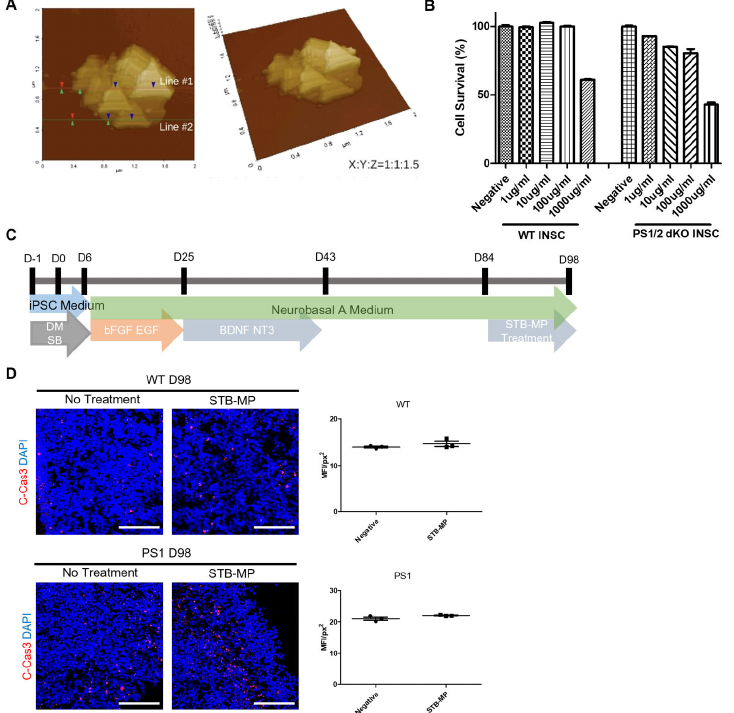
Figure 2. STB-MP nanoparticle characterization. ( A ) AFM image of STB-MP illustrating both the 2D and 3D shapes of the particles. ( B ) Toxicity testing of STB-MP in different cell lines. Serial dilutions from 1000ug/mL to 1µg/mL were used (n = 3). ( C ) Schematic image illustrating the STB-MP treatment schedule. ( D ) Representative images of immunostaining for the apoptotic marker c-Cas3 in WT and PS1 cortical organoids at Day 43 and Day 84 (n = 3). Scale bar 50 µm.